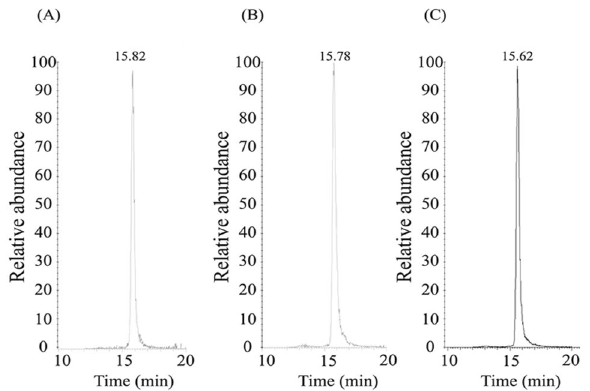
Figure 4. Target glycopeptide analysis for AROPOTIN®, ESPOGEN®, and EPOKINE® at 100 ng/ mL. MS spectra of ( A ) AROPOTIN®, ( B ) ESPOGEN®, and ( C ) EPOKINE®. The target glycopeptide